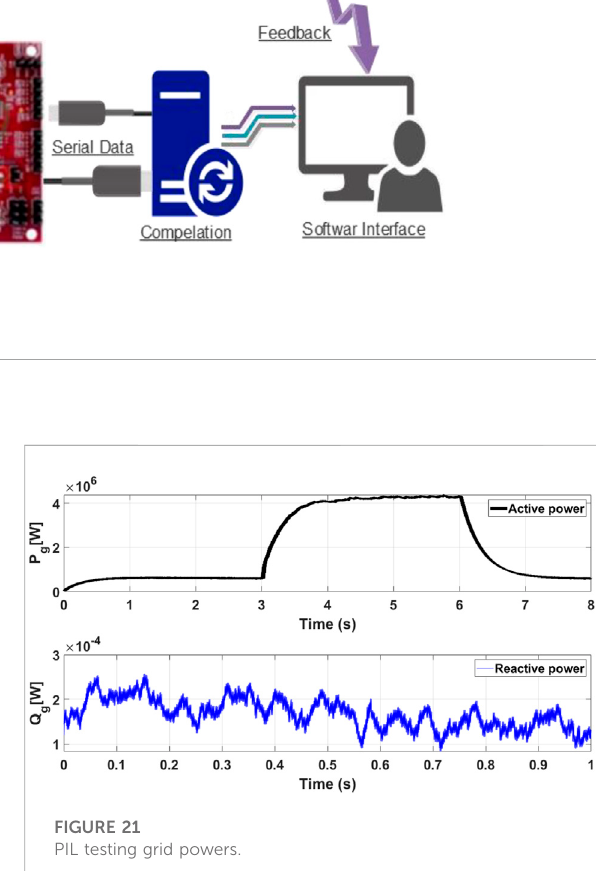
FIGURE 21 PIL testing grid